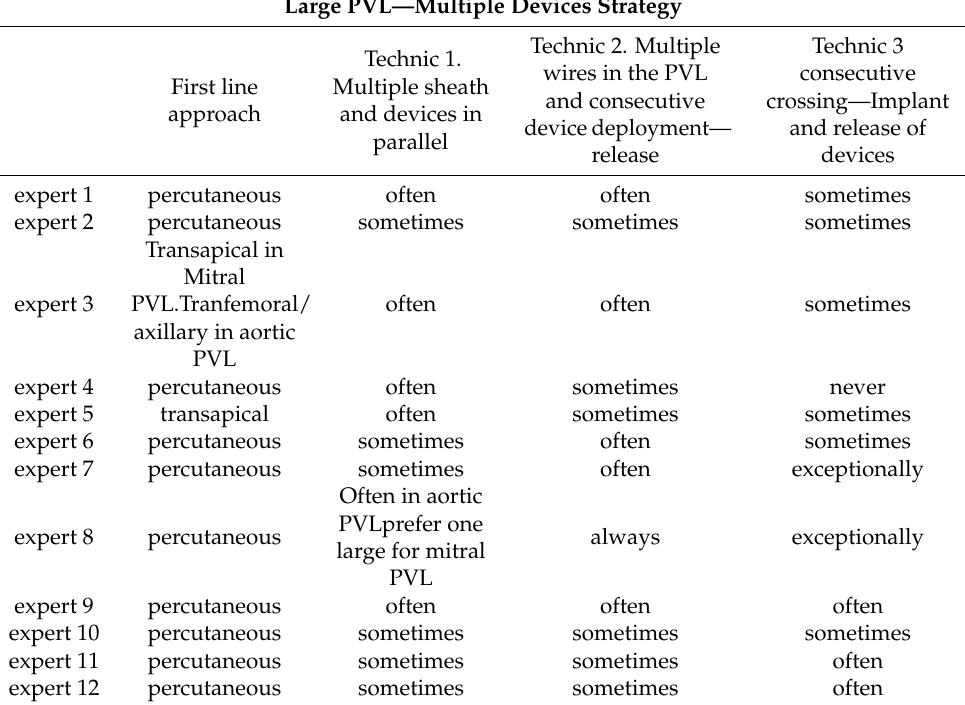
Table 11. tPVLc in large